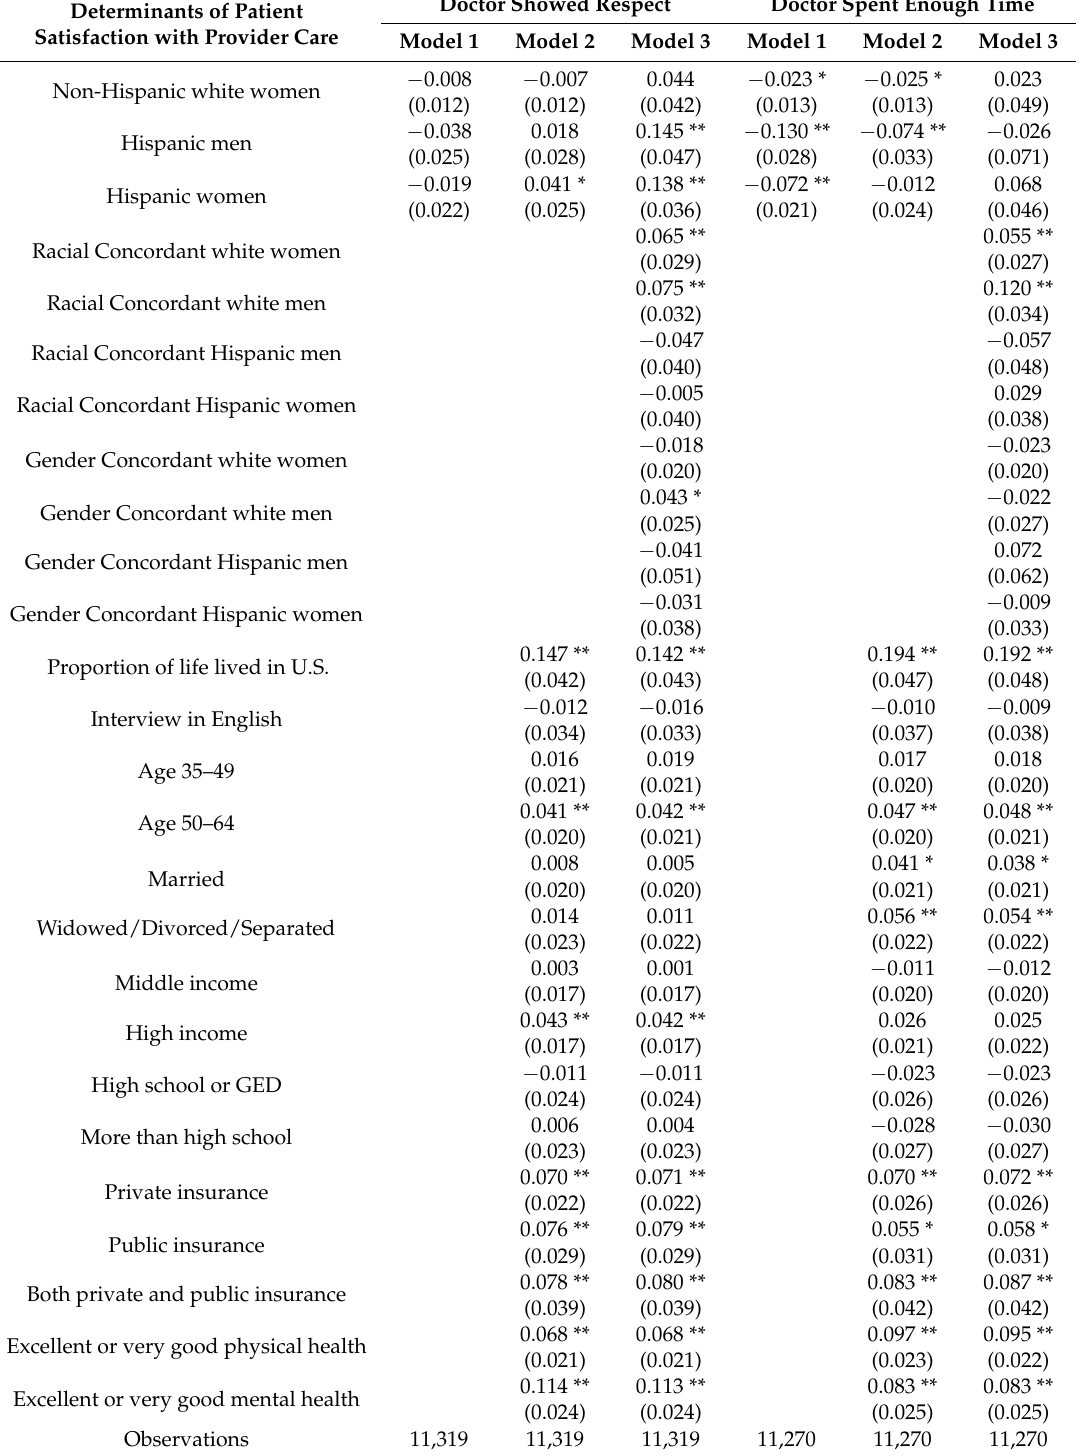
Table 4. Determinants of Patient Satisfaction with Provider